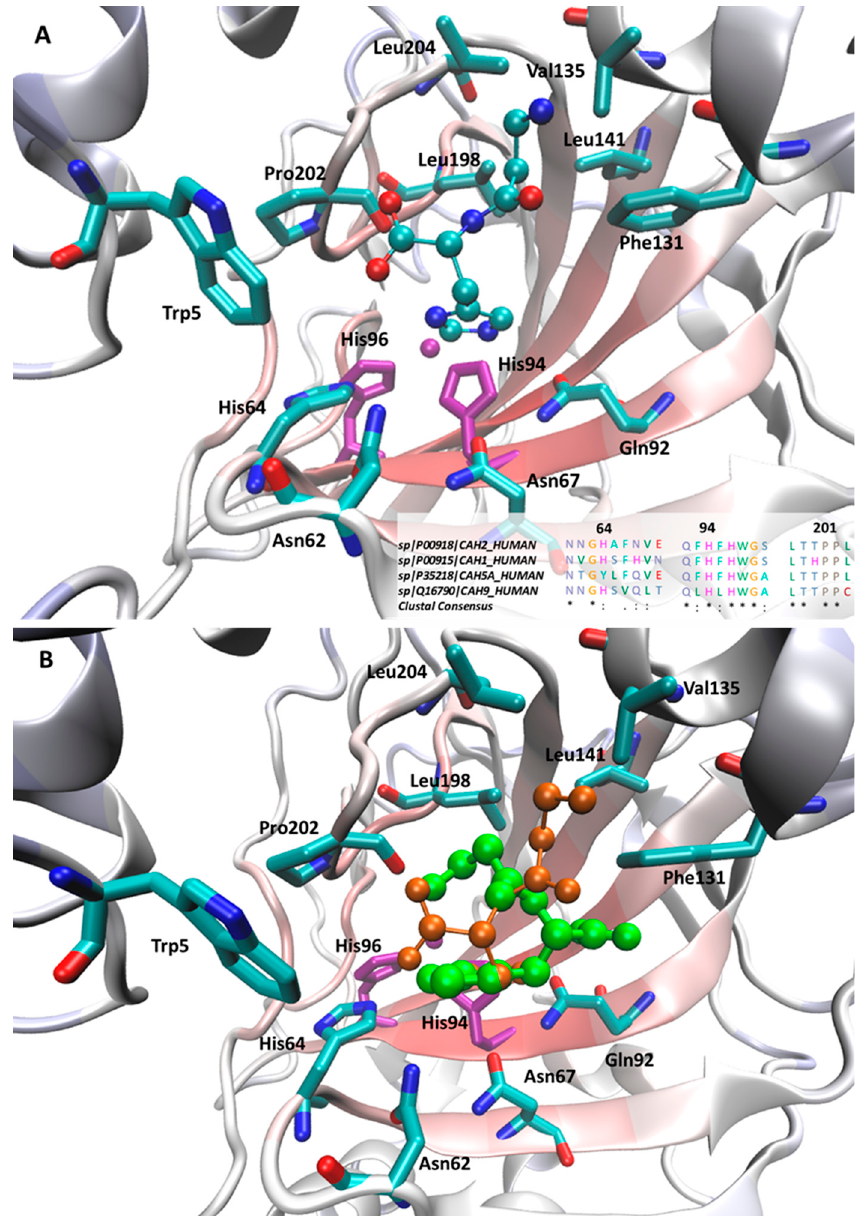
Figure 2. Main interactions stabilizing the putative complexes as computed for d -carnosine ( A ) and comparison between d -carnosine (in orange) and l -carnosine (in green) within the hCA II binding site ( B ). In both Figures, the zinc ion plus the coordinating histidine residues are depicted in purple. The inlet in Figure 2A shows the multiple sequence alignments (and the relative consensus) for the four tested CA isoforms as computed by ClustalX